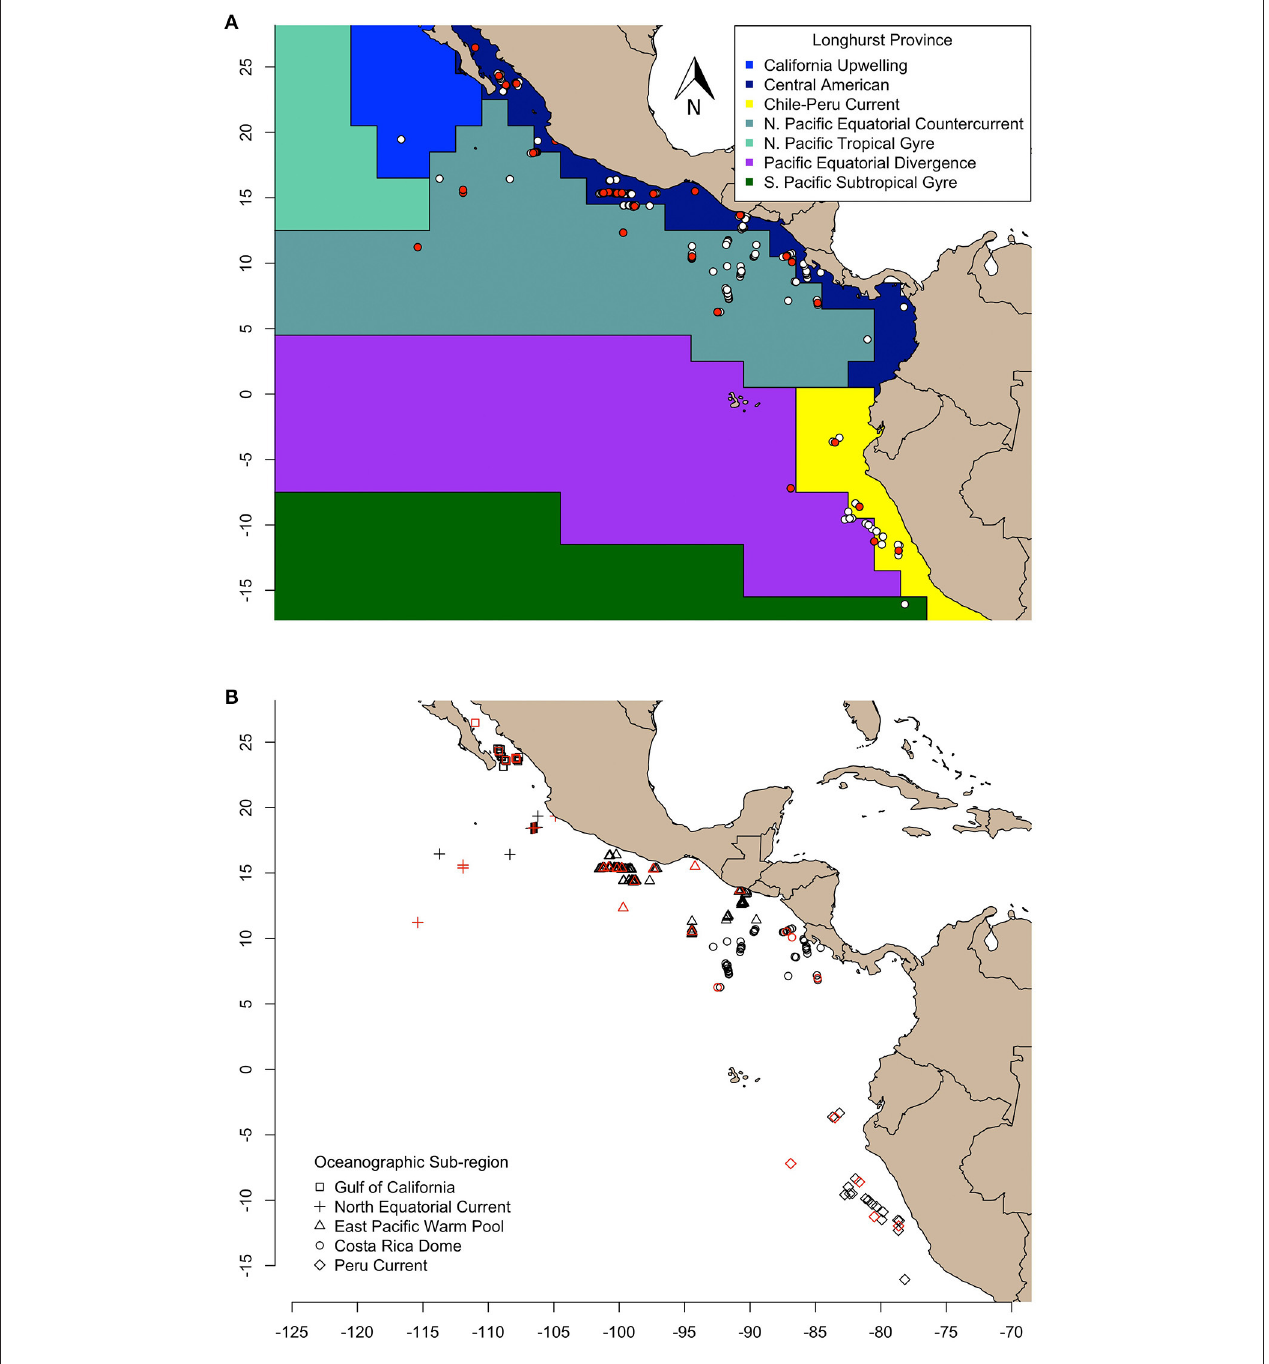
FIGURE 1 | Olive ridley turtles sampled in this study are represented as symbols and aggregated according to (A) Longhurst province (VLIZ, 2009), and (B) oceanographic sub-region (Fiedler and Talley, 2006). The δ 13 C and δ 15 N values of skin of all turtles were determined, and compound specific amino acid δ 15 N values were measured for only those colored in